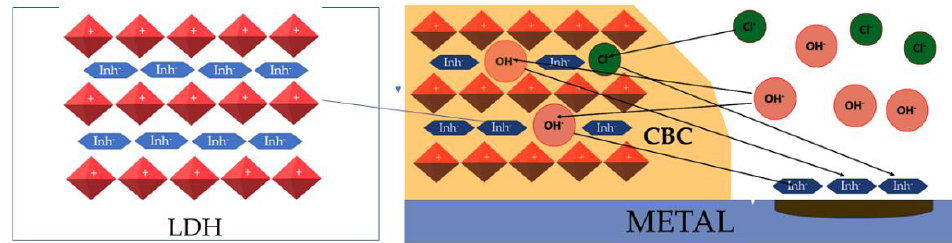
Figure 20. EIS Bode plots of the coatings exposed to 0.5 M NaCl(aq) for 1 h, 144 h, and 288 h.